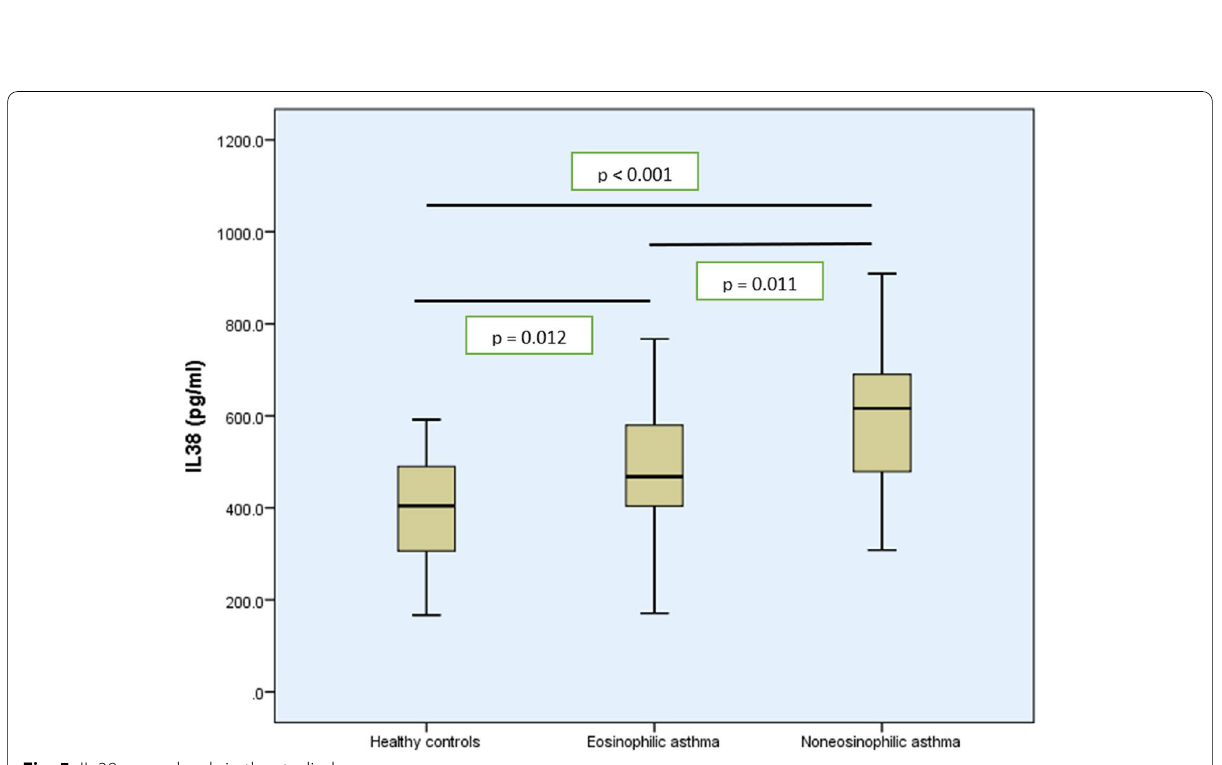
Fig. 5 IL-38 serum levels in the studied